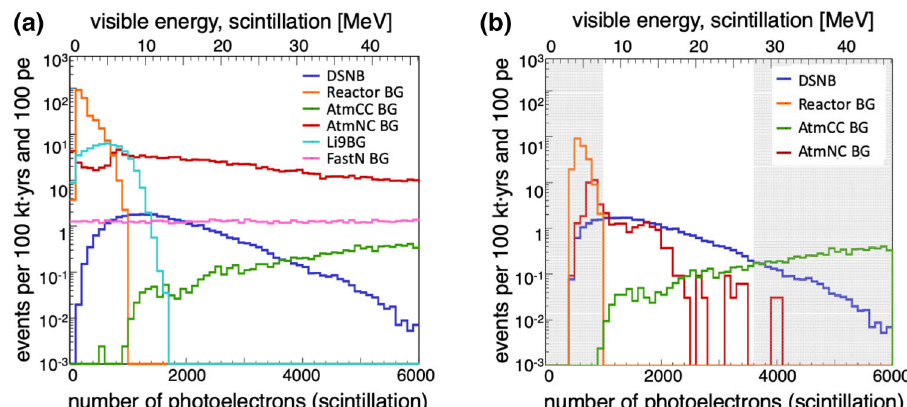
Fig. 14 The visible energy spectrum from scintillation expected for the DSNB signal and its ample backgrounds: While a includes reactor neutrinos, cosmogenic Li-9, fast neutrons as well as atmospheric neu- trino CC and NC interaction rates before application of discrimination